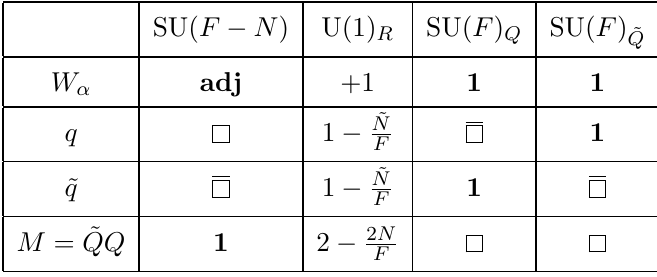
Table 2 . Quantum numbers of fields in the magnetic SU(